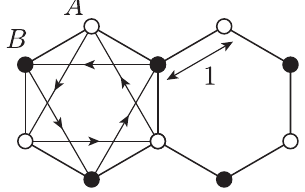
1 ( − 1 ) if the hopping . ν ij ij ¼ þ